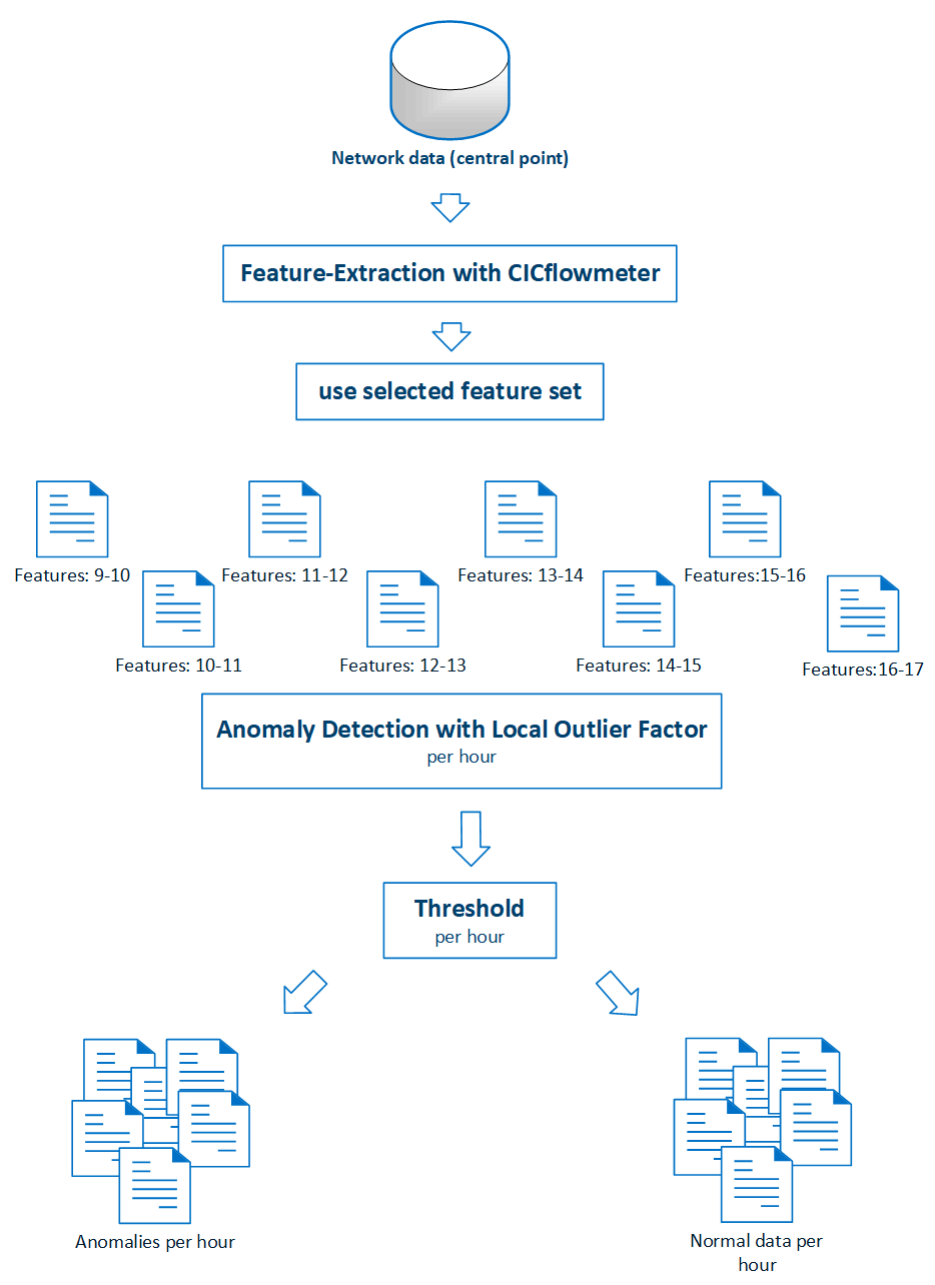
Figure 9. Detection approach with the local outlier factor